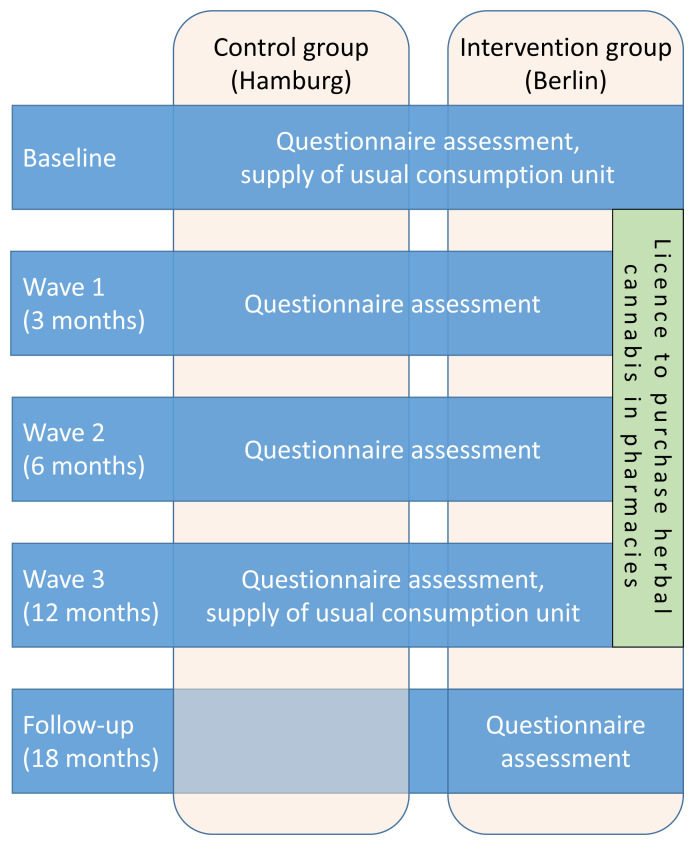
Study flow chart.